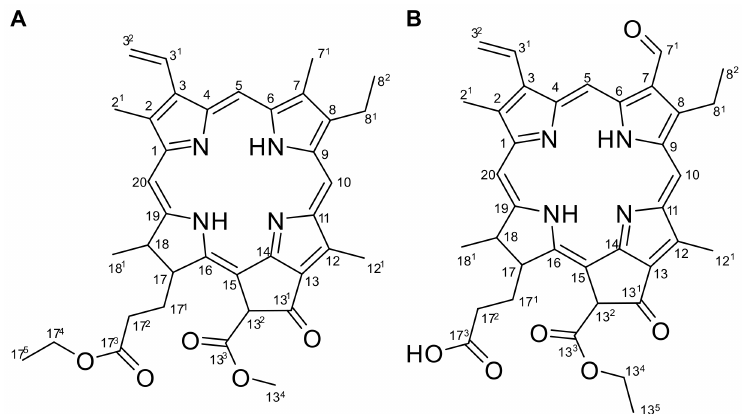
Figure 2. Ethyl pheophorbides a ( A ) and b ( B ) obtained from